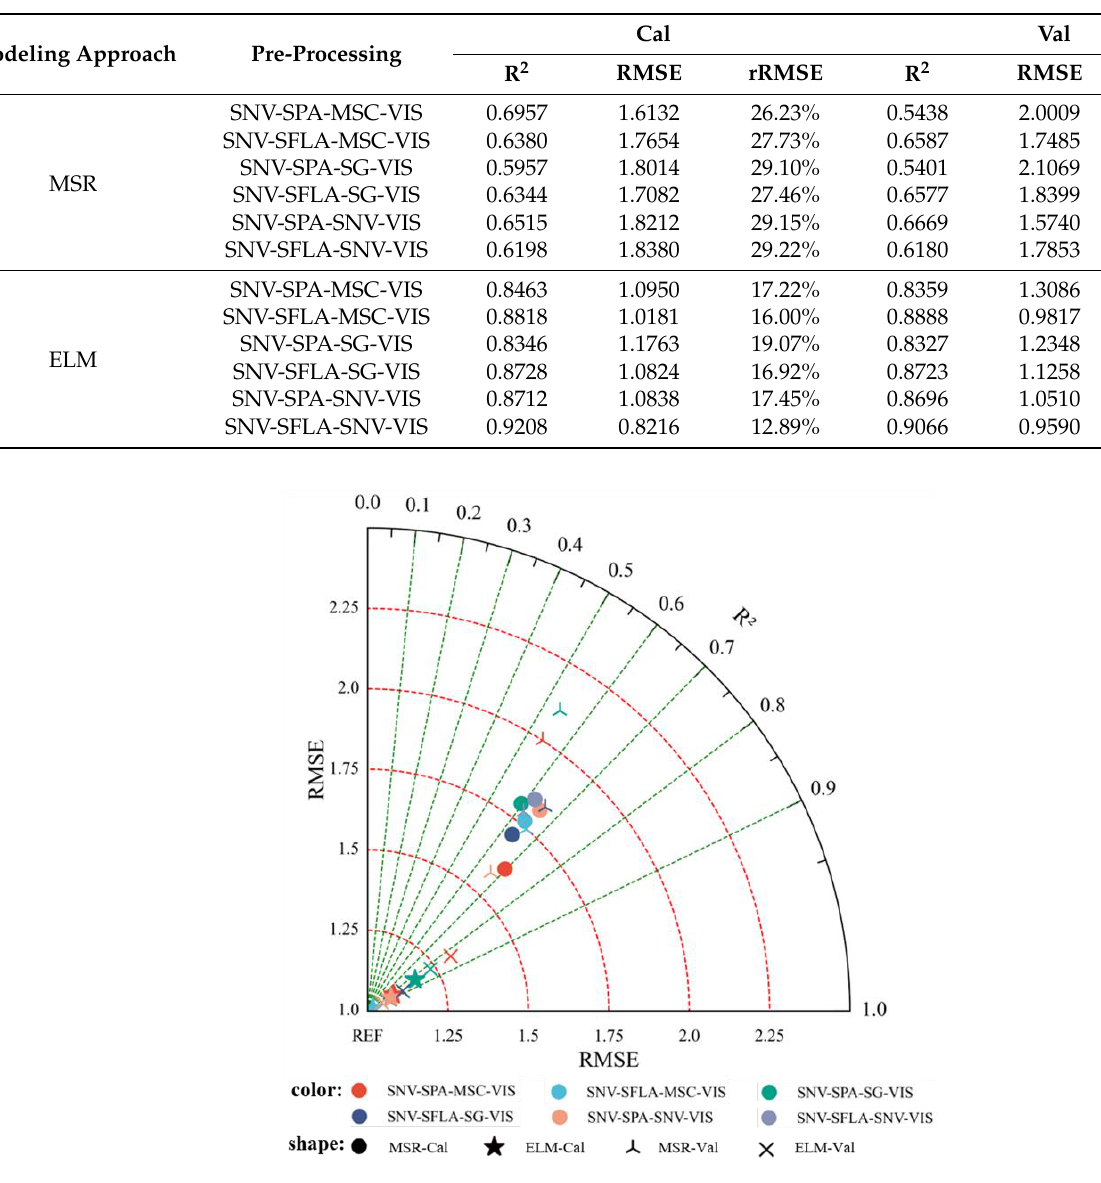
Figure 11. Cotton LAI monitoring model training sets (Cal) and validation sets (Val) result based on combination of spectral reflectance and vegetation indices: resultant Taylor diagram.